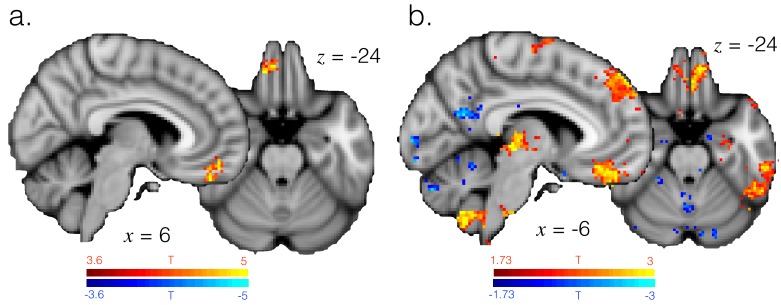
Representation strength in mOFC is explained by probability assigned to the currently selected option, as well as the difference between high and low reward exploit periods.(a) T-statistic map showing model probability explains representation strength specifically in mOFC, as in GLM5. Image thresholded at p<0.001; corrected for multiple comparisons. (b) T-statistic map showing regions where representation strength is higher in high (90%) vs. low (70%) reward exploit periods. Image thresholded voxelwise at p<0.05, uncorrected.